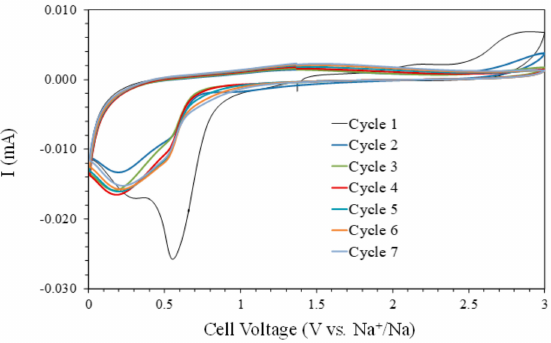
Figure 3. The cyclic voltammetry curves (5 mV min − 1 ) of the NiO films prepared on Cu